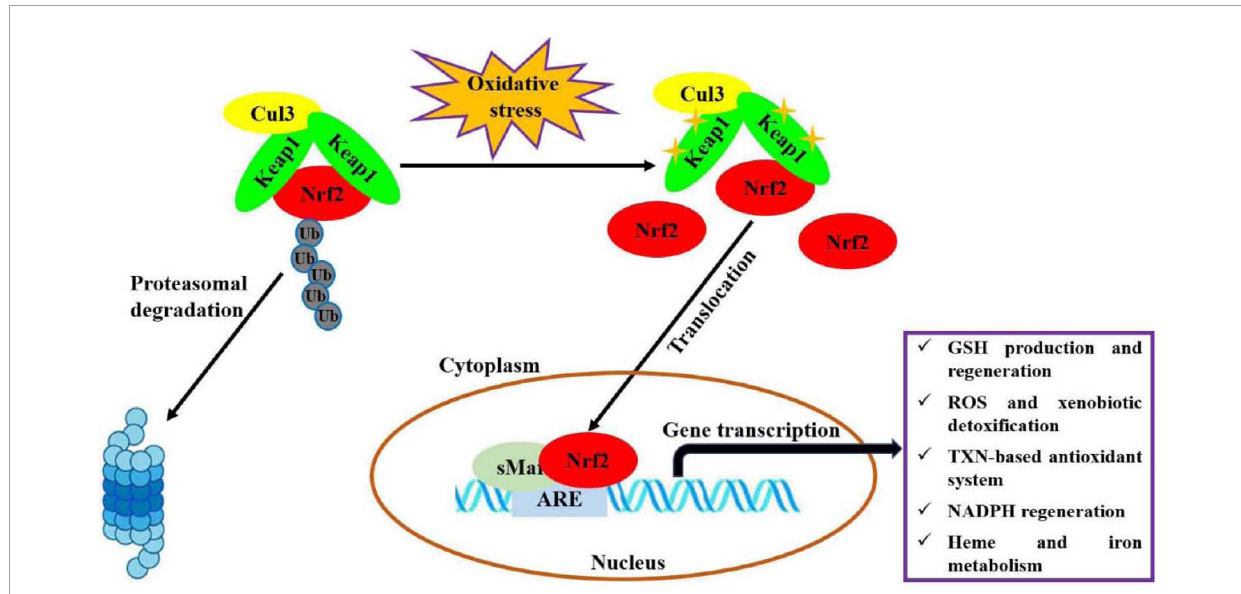
FIGURE1 Molecular mechanism of Nrf2 signaling pathway regulating oxidative stress (7, 8). This figure is adapted from Transcriptional Regulation by Nrf2 by Claudia Tonelli et al., and NRF2, a Transcription Factor for Stress Response and Beyond by He et al., under CC BY 4.0.